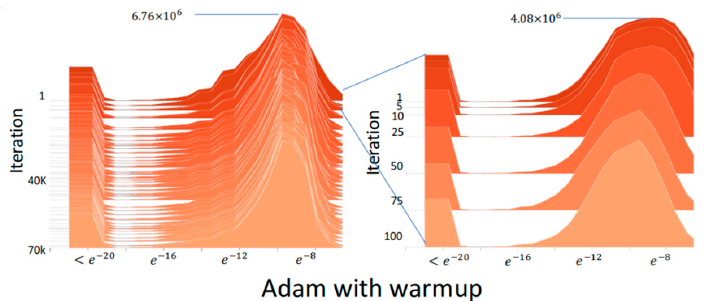
Figure 3. The absolute gradient histogram during training a DNN using Adam without warmup for machine translation on the IWSLT2014 De-En dataset [14].